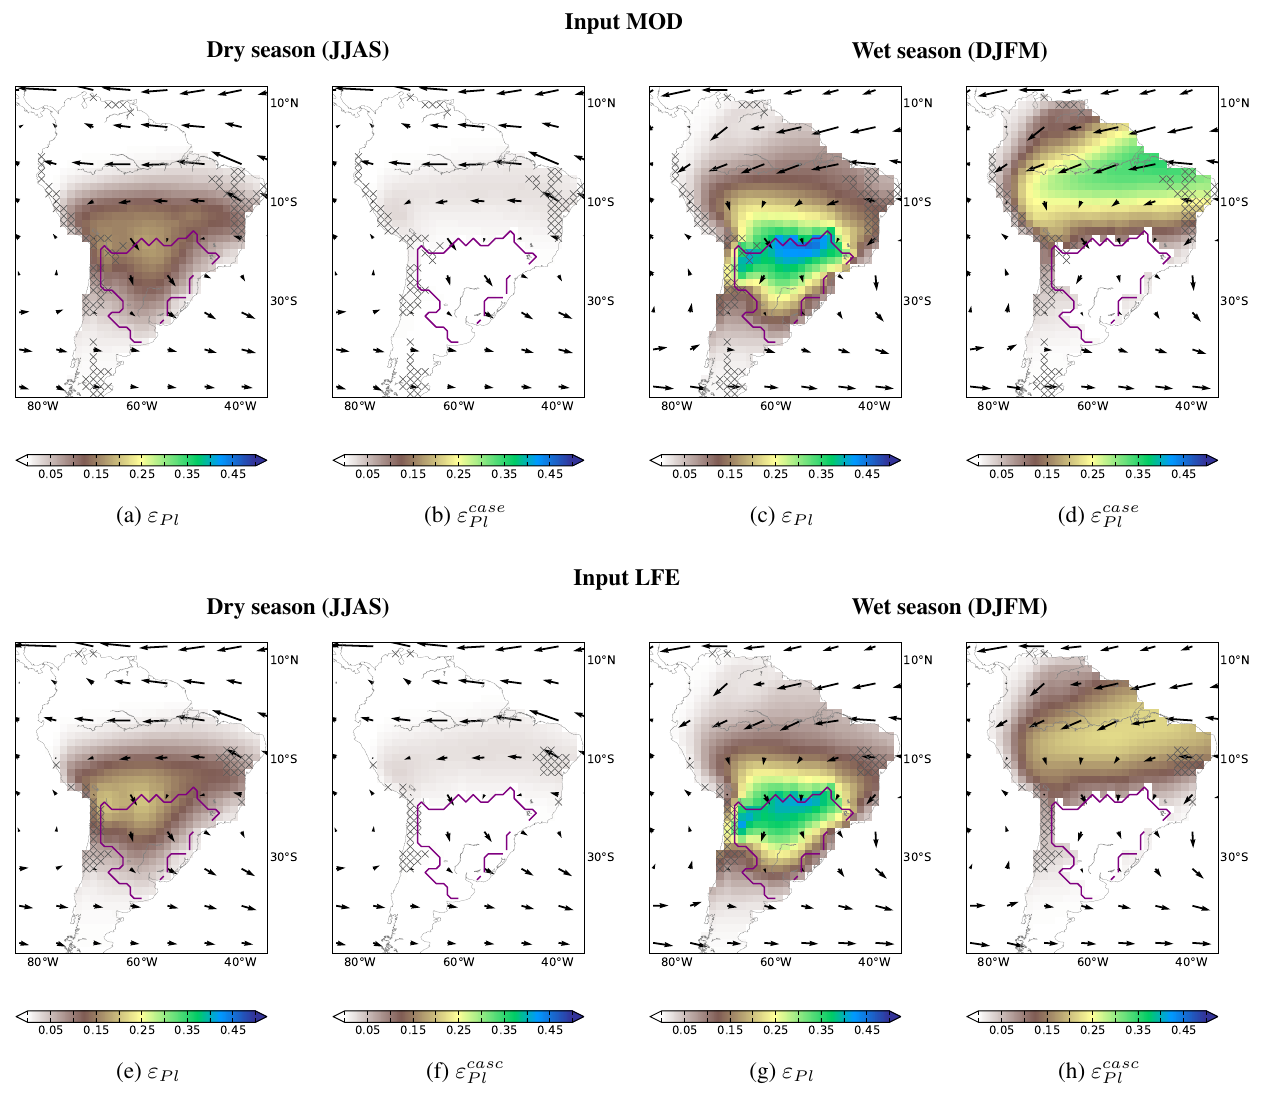
Figure 7. Fraction of evapotranspiration that precipitates over the La Plata basin (defined by the purple boundaries) through DMR ( ε Pl , a , c , e and g ) and CMR ( ε casc , b , d , f and h ). Considered together, ε Pl and ε casc show source regions of precipitation over the La Plata basin. Results are obtained using the input MOD (upper row) and input LFE (lower row) (see Table 1) and are given for the dry season (left) and the wet season (right).